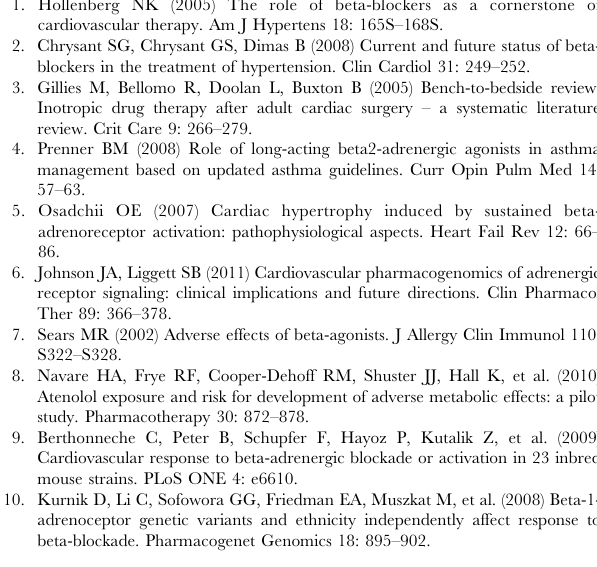
Figure S9 Distribution of cardiac mRNA expression levels as measured by microarrays. The mixture of two Gaussian functions was fitted to the log expression values. The first component, peaking at around 2, fits the non-expressed genes, whereas the second component, peaking at around 6.5, fits the expressed genes. Non-expressed genes are those which belong to the first component with at least 95% confidence, i.e., those genes that have a log expression value less than 2.33 (red line). Figure S10 Boxplots showing the SBP values of 22 strains treated with ate (in red) and iso10 (in blue). Strains are segregated according to their genotype at marker rs29354390 in Trhrde (locus AE6). Figure S11 Analysis flowchart . This flowchart summarizes the analysis of the 27 phenotypes measured across the 22 inbred strains. Details referring to the boxes shaded in grey have been published previously [9]. These phenotypes are also freely available through the Mouse Phenome Database (project Maurer1; http://phenome.jax.org/). Analyses of the drug re- sponses were performed following a similar scheme, except that the values were not physically measured in individual mice but approximated, as detailed in the main text. Table S1 Phenotypes and abbreviations used in this study. Table S2 Heritabilities ( h 2 ) for 27 traits and trait responsiveness to ate and iso , as computed by EMMA. The values of the genetic variance components for the various traits and responses were computed by fitting EMMA without any SNP but just using the kinship matrix [20]. On average, the